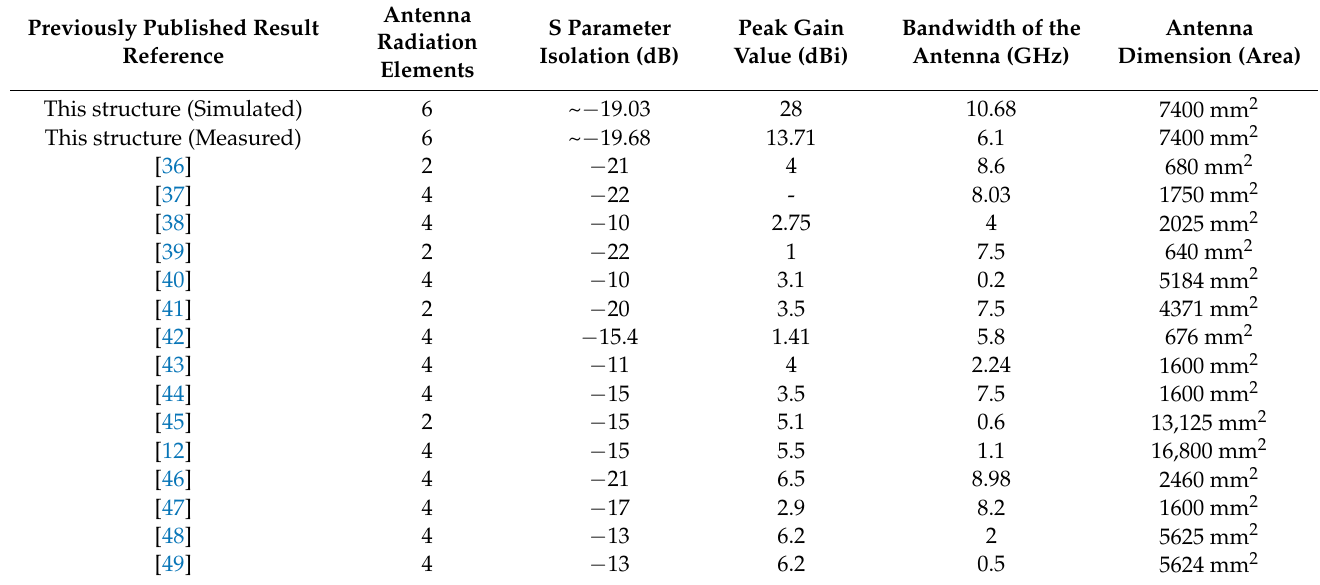
Table 5. Comparison of the results derived in the proposed antenna and previously published